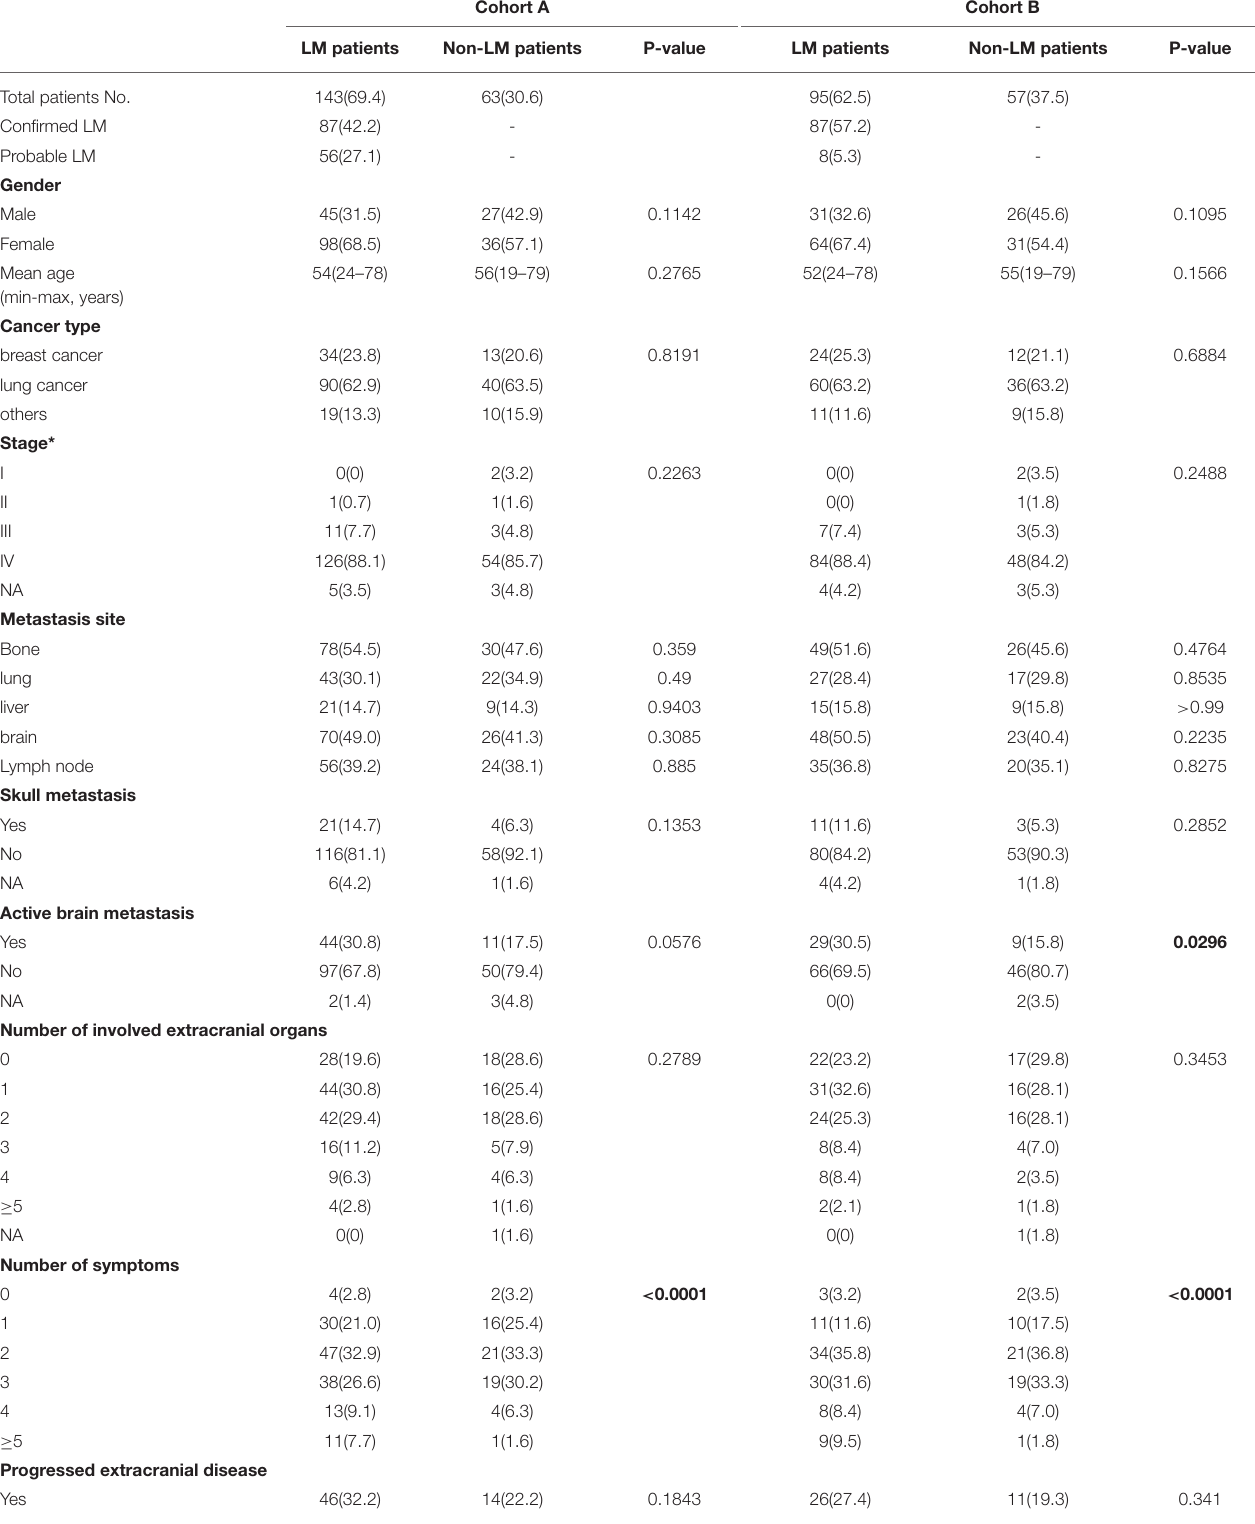
TABLE 1 | Differences of clinical characteristics between patients with leptomeningeal metastasis (LM) and non-LM. Cohort A Cohort B LM